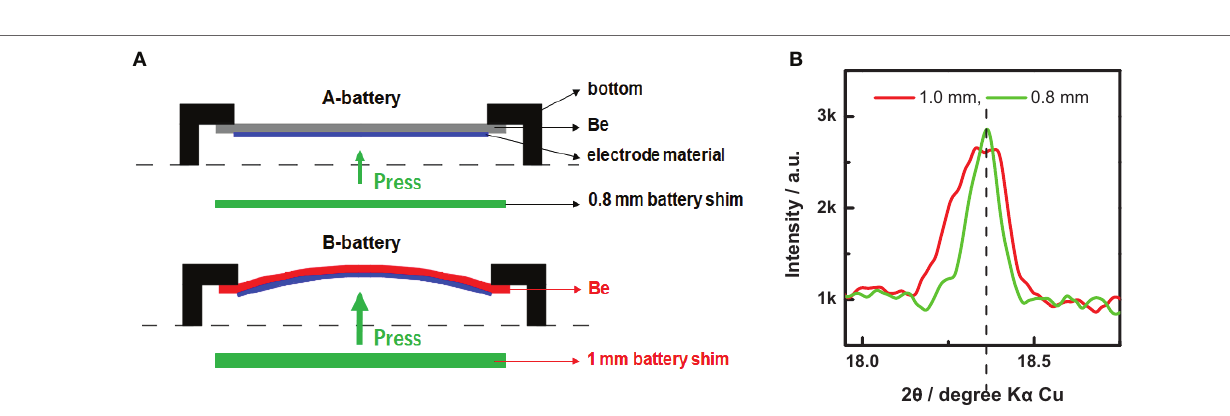
FigUre 2 | In situ X-ray diffraction (XRD) measurement with different Be sheets. The in situ XRD results of LiFePO 4 with a Be sheet of (a) 0.2 mm and (B) 0.5 mm thick, respectively. “H” represents heterosite (lithium-poor phase, FePO 4 ), “T” represents triphylite (lithium-rich phase, LiFePO 4 ).